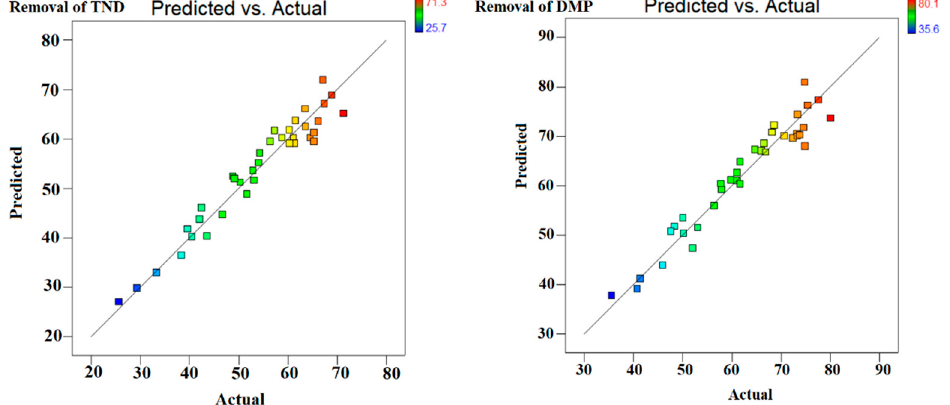
Figure 5. Design expert statistical plots for removal of TND and DMP.